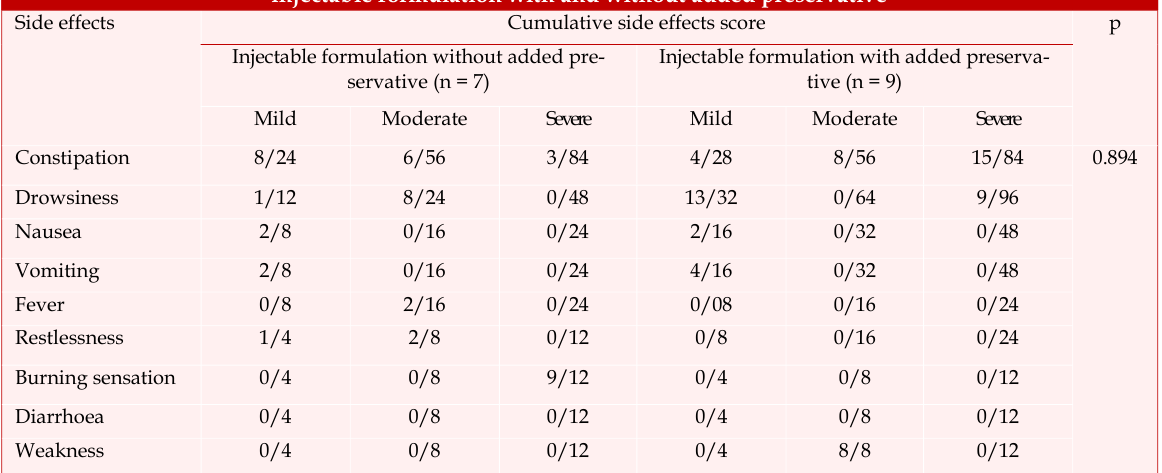
Cumulative side effects score after administration of morphine solution prepared with morphine sulphate injectable formulation with and without added